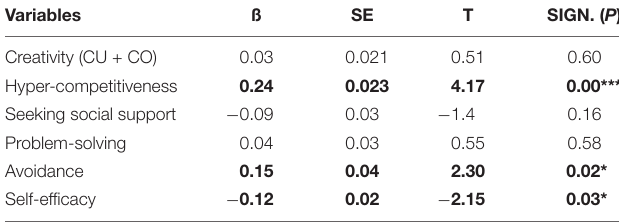
TABLE 2 | Summary model with PG